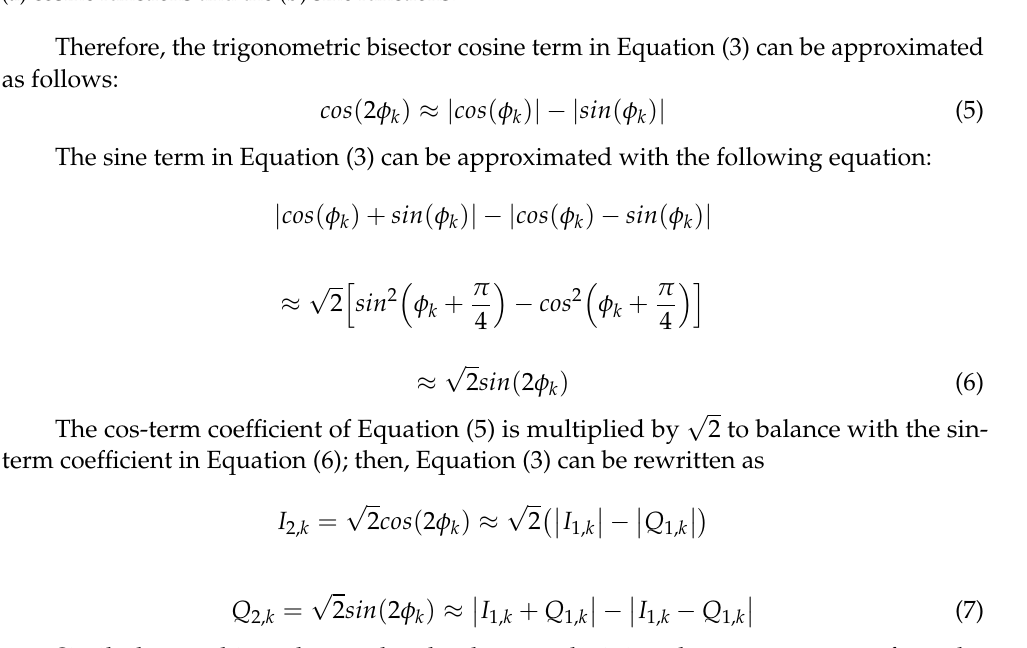
Figure 3. Comparison of the results of the absolute-value operation and the square operation of the ( a ) cosine functions and the ( b ) sine functions.